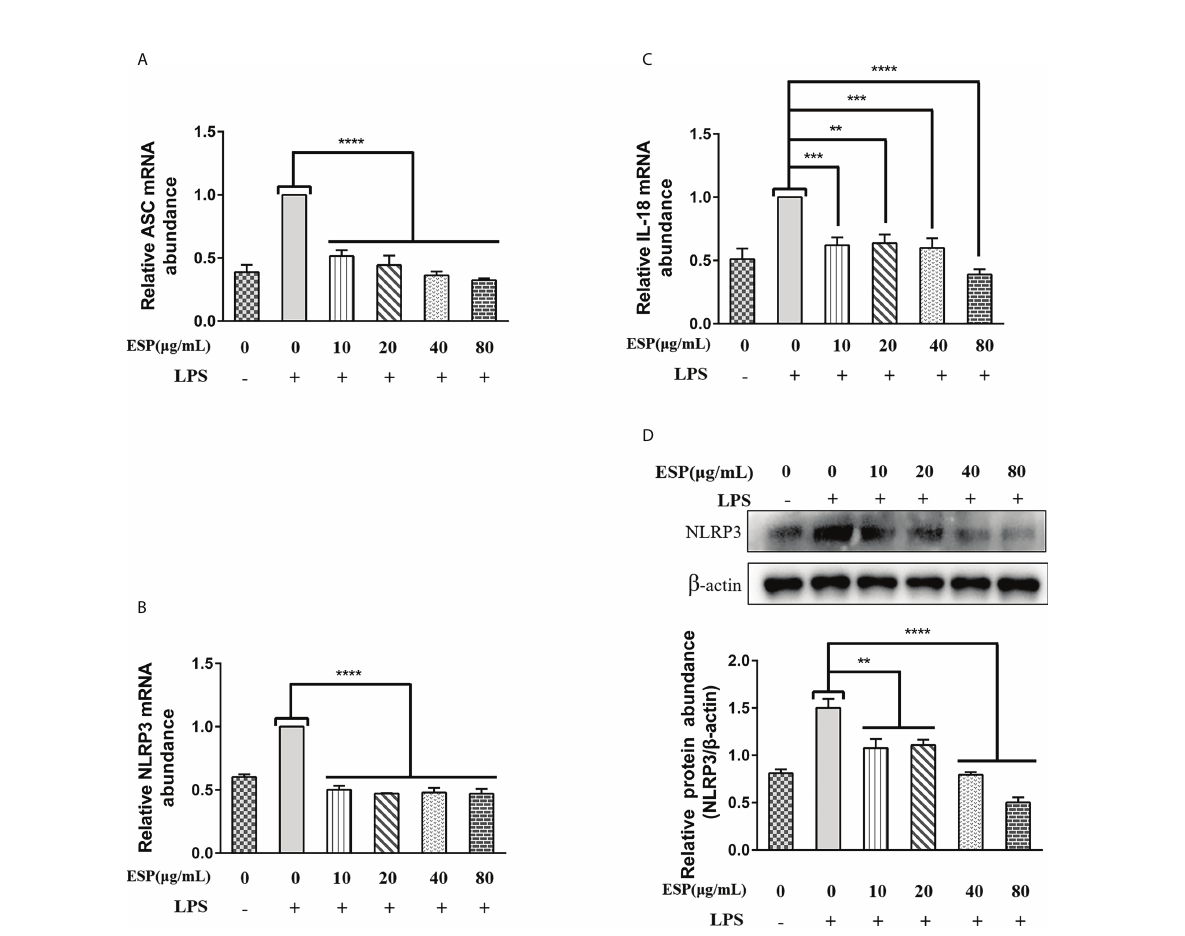
FIGURE 7 HcESPs inhibited the NLRP3 signaling pathway in PBMCs. Cells were stimulated with LPS (1 m g/mL) to establish an in fl ammation model, and incubated with different concentrations (10, 20, 40, 80 m g/mL) of HcESPs or equal volume of RPMI 1640 medium at 37°C and 5% CO 2 for 24 h. A blank control group was set up (equal volume of RPMI 1640 instead of LPS and HcESPs). (A – C) : Detection of relative transcript levels of ASC, NLRP3, and IL-18 in PBMCs by qPCR assays; (D) : Detection of relative protein expression of NLRP3 by Western blot; Data are presented as the mean±SEM from three independent experiments. Asterisks indicate signi fi cant differences at ** P <0.01, *** P <0.001, and **** P